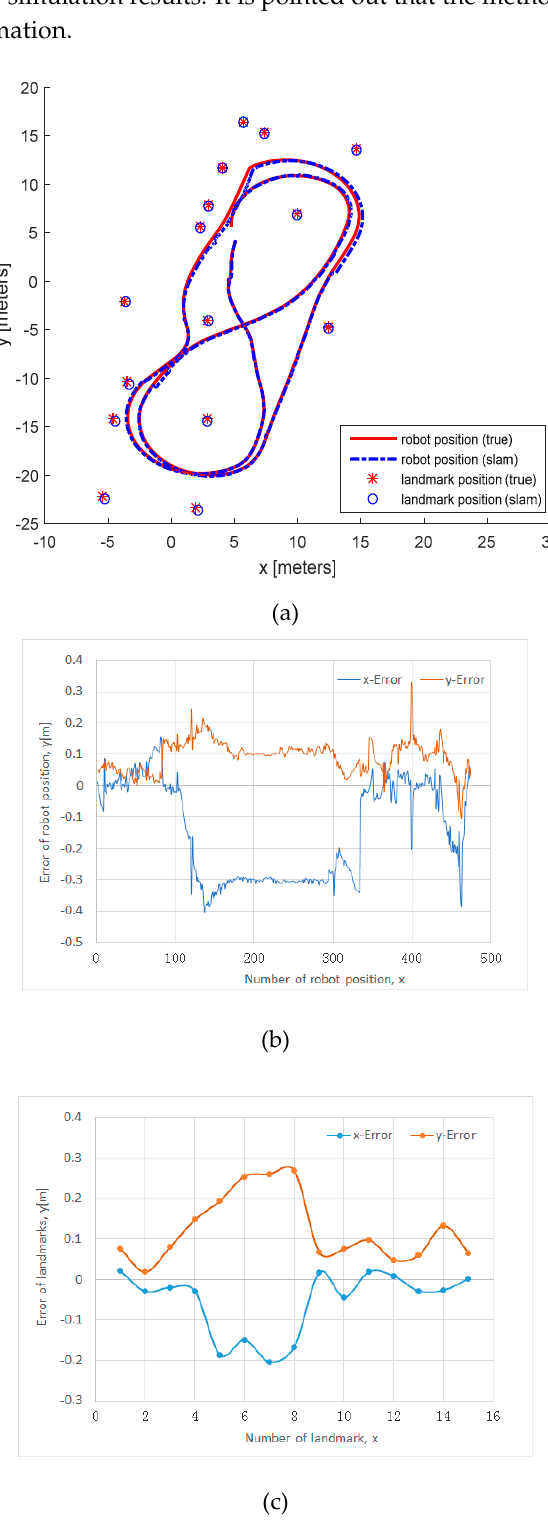
Figure 9. Simulation results for SLAM with no noise in the sound signal: ( a ) EKF-SLAM for a mobile robot based on microphone landmark observations; ( b ) robot position errors in the x - and y -directions; and ( c ) landmark position errors in the x - and y -directions.